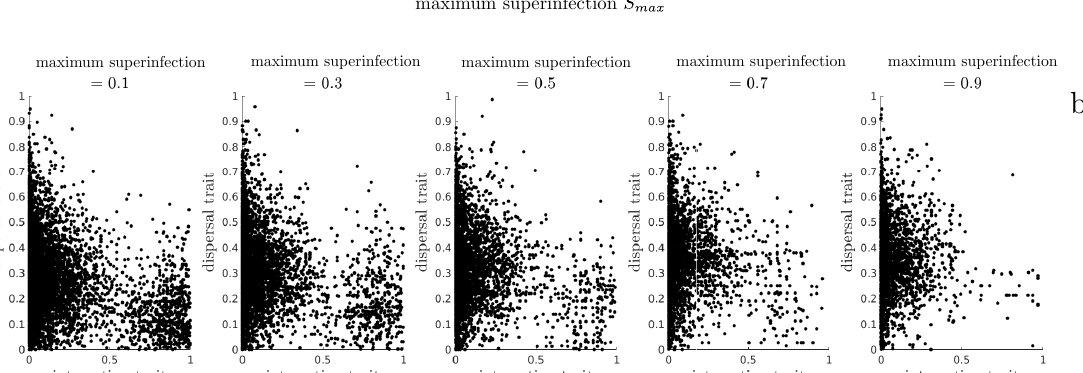
h = 0 . 1 , f s = 2 . 5 , f max = 8 , f a = 0 . 5 and β max = 0 . 5 min min